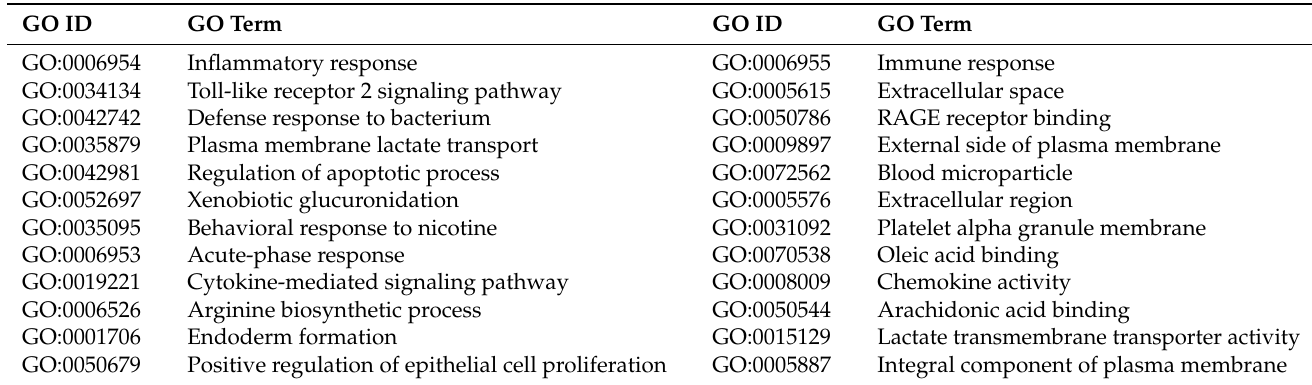
Table 3. GO ID associated with the GO